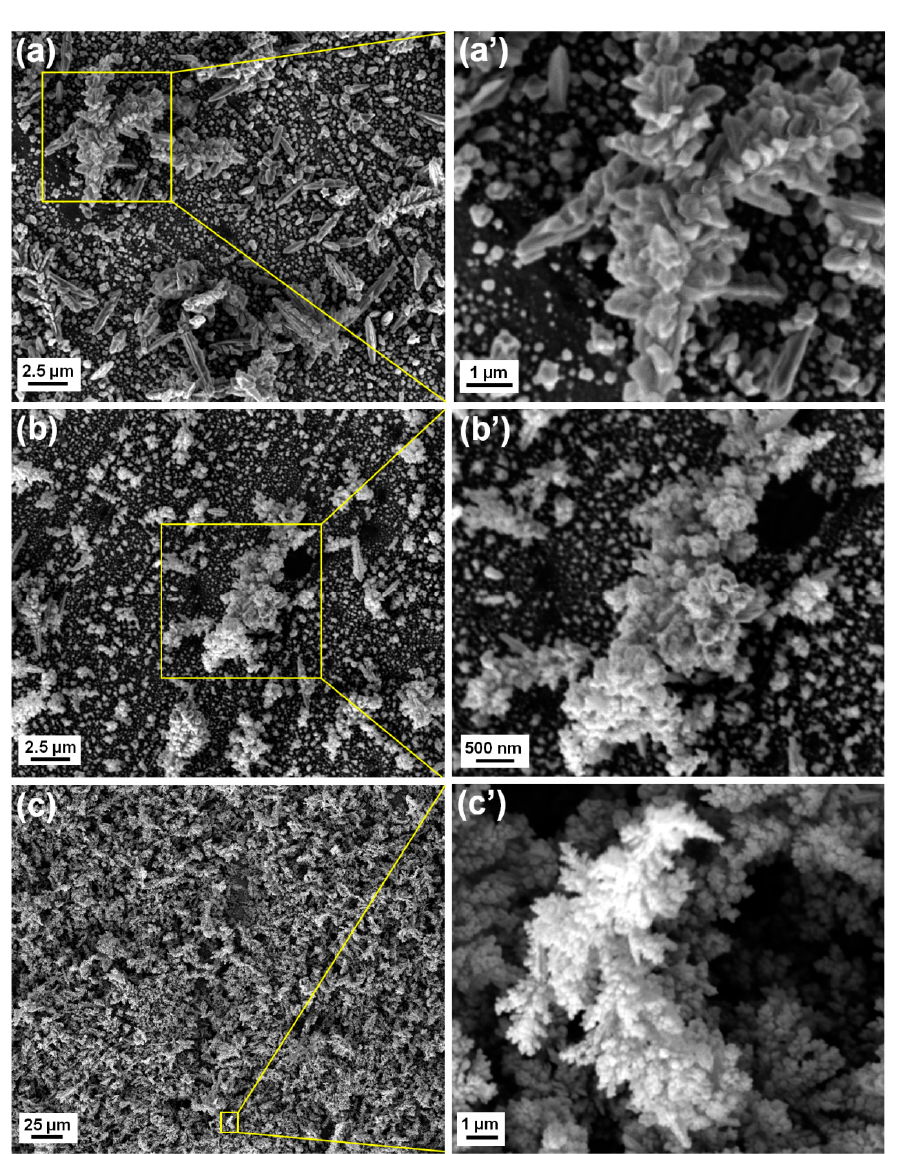
Figure 4. SEM images of ( a ) Pd90s, ( b ) Pd180s, and ( c ) Pd300s while ( a ’), ( b ’), and ( c ’) provide a closer look at the growing dendrites of the samples, respectively.